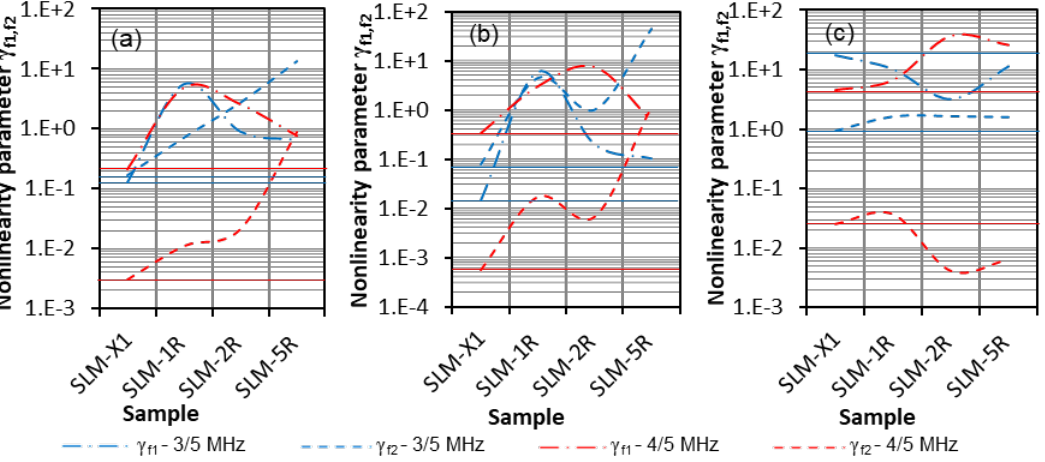
γ γ α = 45 ◦ ; ( b ) α = 60 ◦ ; ( c ) α = 90 ◦ f 1 and f 2 parameters: ( a )